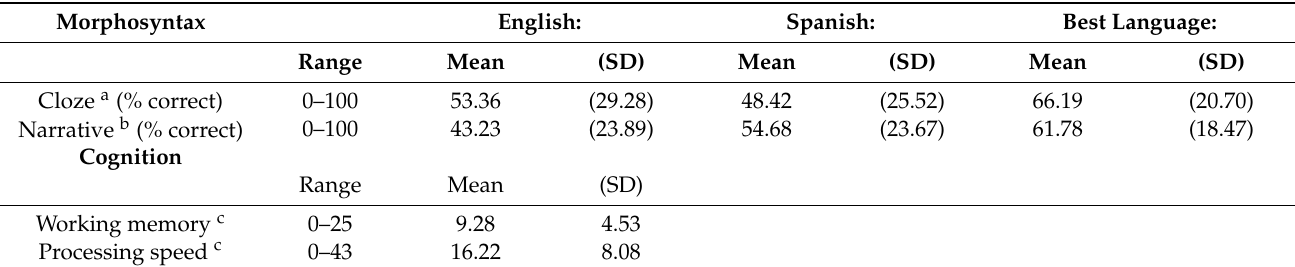
Table 2. Morphosyntactic performance (by language) and nonverbal cognitive performance.